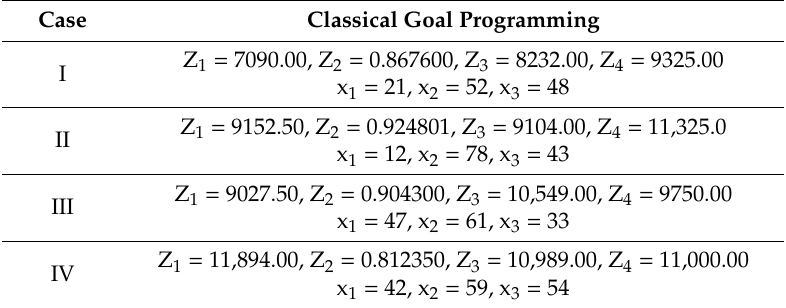
Table 5. Compromise solution.